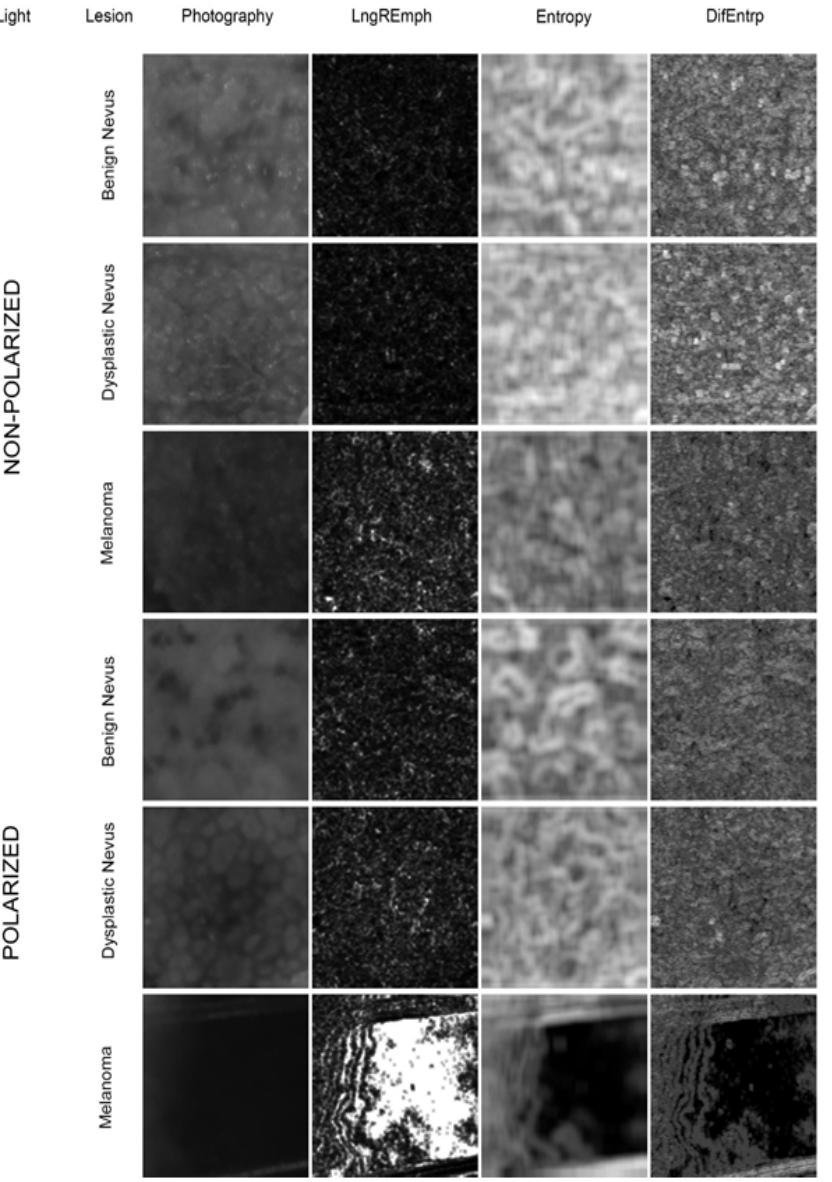
Figure 1. Digital texture analysis of ROI from images of pathological lesions. In the first column from the left are images taken under non-polarized and polarized light of benign pigmented nevus, dysplastic nevus, and melanoma. In the second column from the left, surface intensity distribution maps of the feature describing the frequency of occurrence in the image of long rows of pixels of similar brightness (LngREmph) are presented. In this case, uniformly dark areas were detected. The third and fourth columns show the distribution maps of two texture features describing the randomness of the image structure pattern (Entropy and DifEntrp). The brighter areas define the locations of more chaotically arranged patterns in the skin lesion. Note the complete degradation of the image pattern observed under polarized light in malignant